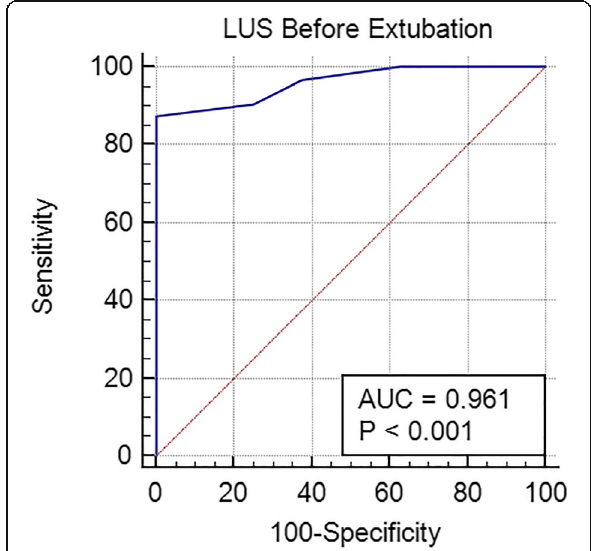
Fig. 6 Receiver operator characteristic (ROC) curve showing sensitivity, specificity, and area under the curve (AUC) for lung ultrasound scores in neonates on SIMV mode before